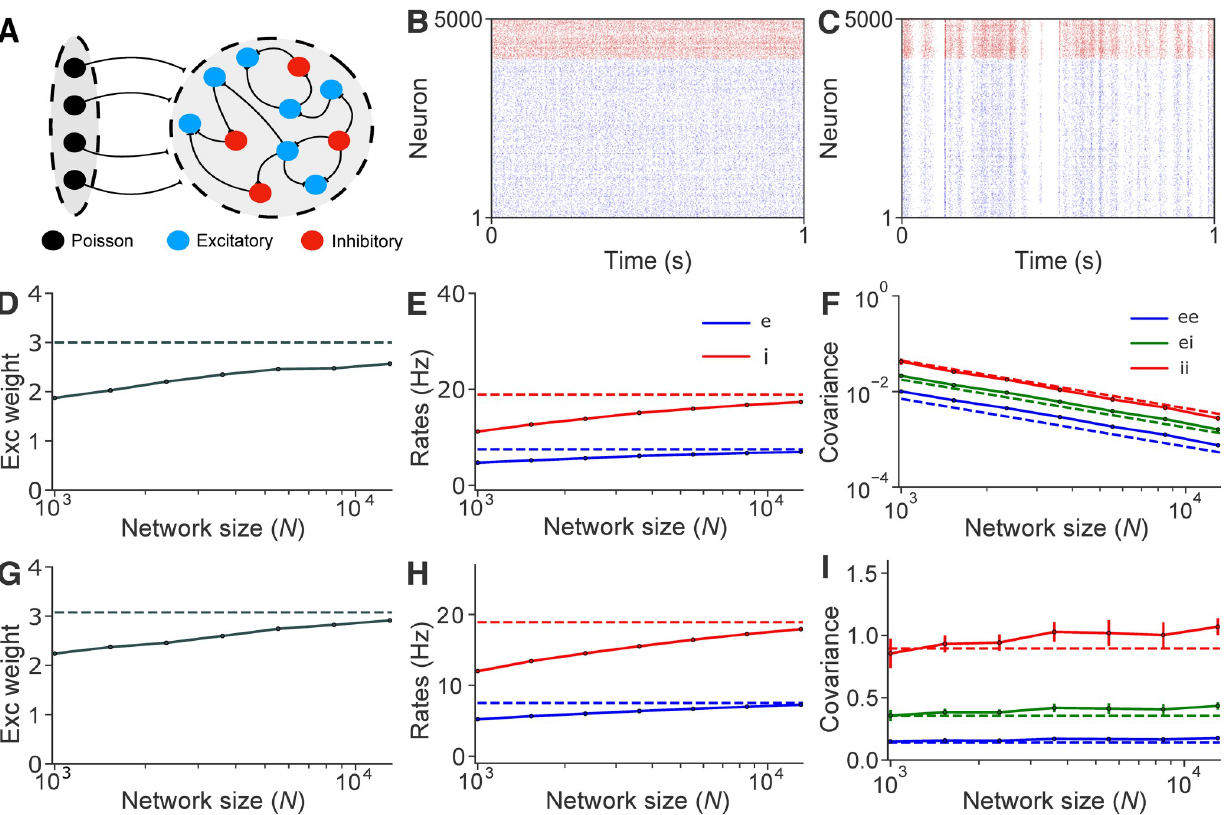
Fig 1. A plastic, balanced network in asynchronous and correlated regimes. A : A recurrent network of excitatory, E , and inhibitory, I , neurons is driven by an external feedforward layer, X , of correlated Poisson neurons. B : Raster plot of all neurons in a network of N = 5000 neurons in an asynchronous state. E cells in blue, I neurons in red. C : Same as ( B ), but in a correlated state. D : Mean steady state EE synaptic weight, j ee , in an asynchronous state. E : Mean E and I firing rates for different network sizes, N , in an asynchronous state. F : Mean EE, II and EI spike count covariances in an asynchronous state. G–I : Same as ( D–F ) but for a network in a correlated state. Solid lines represent simulations, and dashed lines are values obtained using Eqs (3), (5) and (21). All empirical results were averaged over 10 realizations. In the asynchronous state c x = 0, and in the correlated state c x = 0.1. Unless otherwise stated, colors carry the same meaning in all